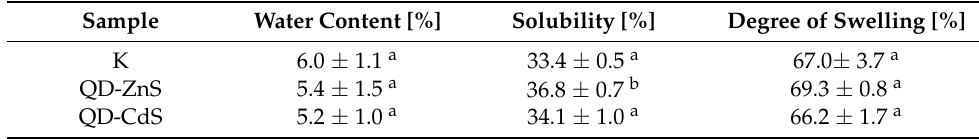
Table 3. Water content, solubility, and degree of film